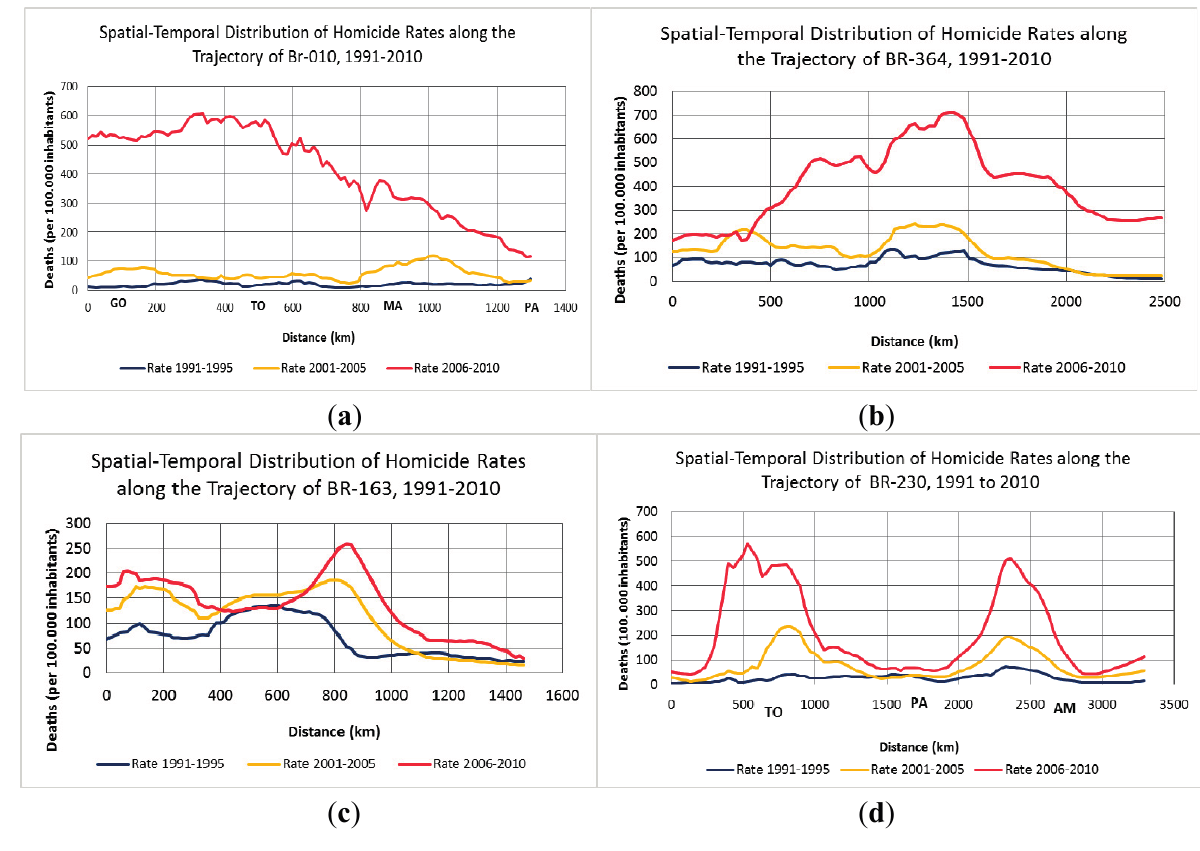
Figure 2. Interpolated homicide rates along the primary highways of the Legal Amazon (BR-010, BR-230, BR-163 and BR-364). Source: SIM/DATASUS (http://sim.saude.